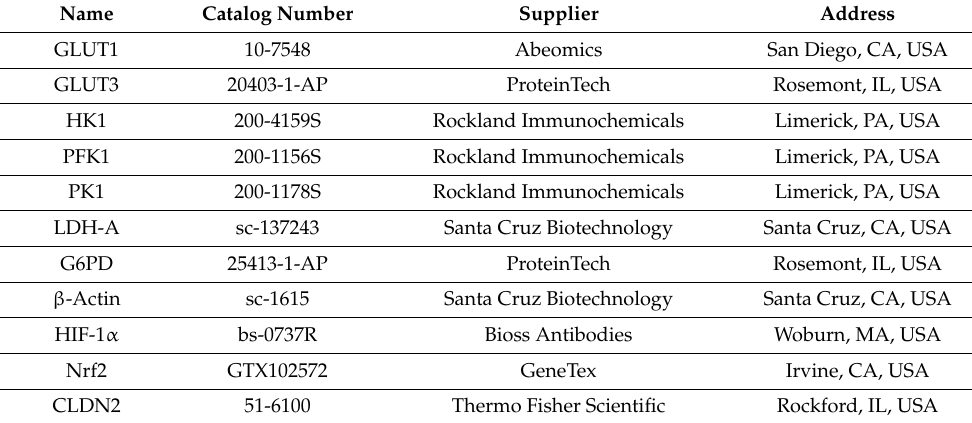
Table 2. Primary antibodies for Western blotting and